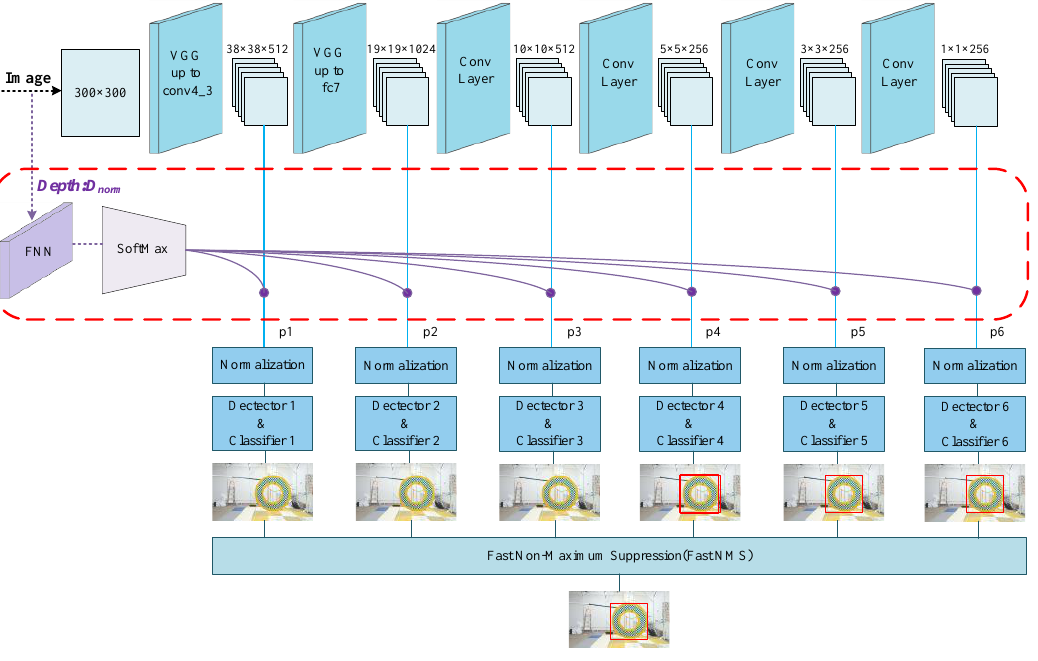
Figure 4. Structure of Fast Depth-Assisted Single-Shot MultiBox Detector.